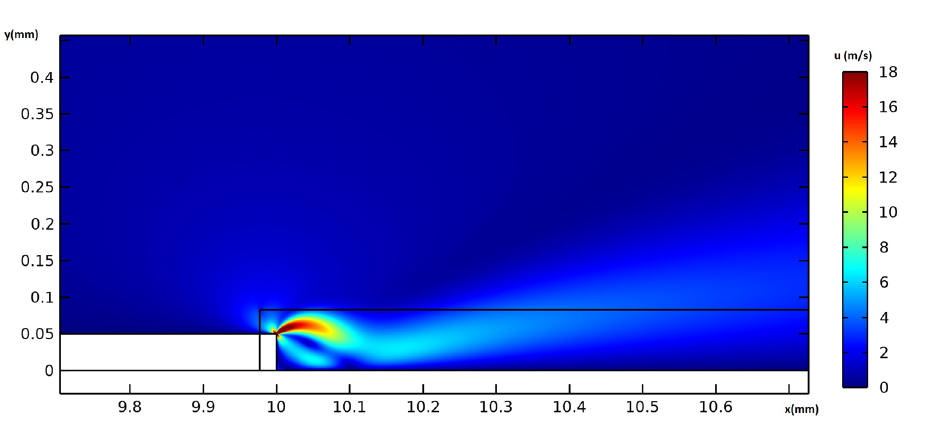
Figure 13. The flow velocity field around the actuator in ms − 1 , for the actuation case of V = 7.2 kVpp and f = 8 kHz.